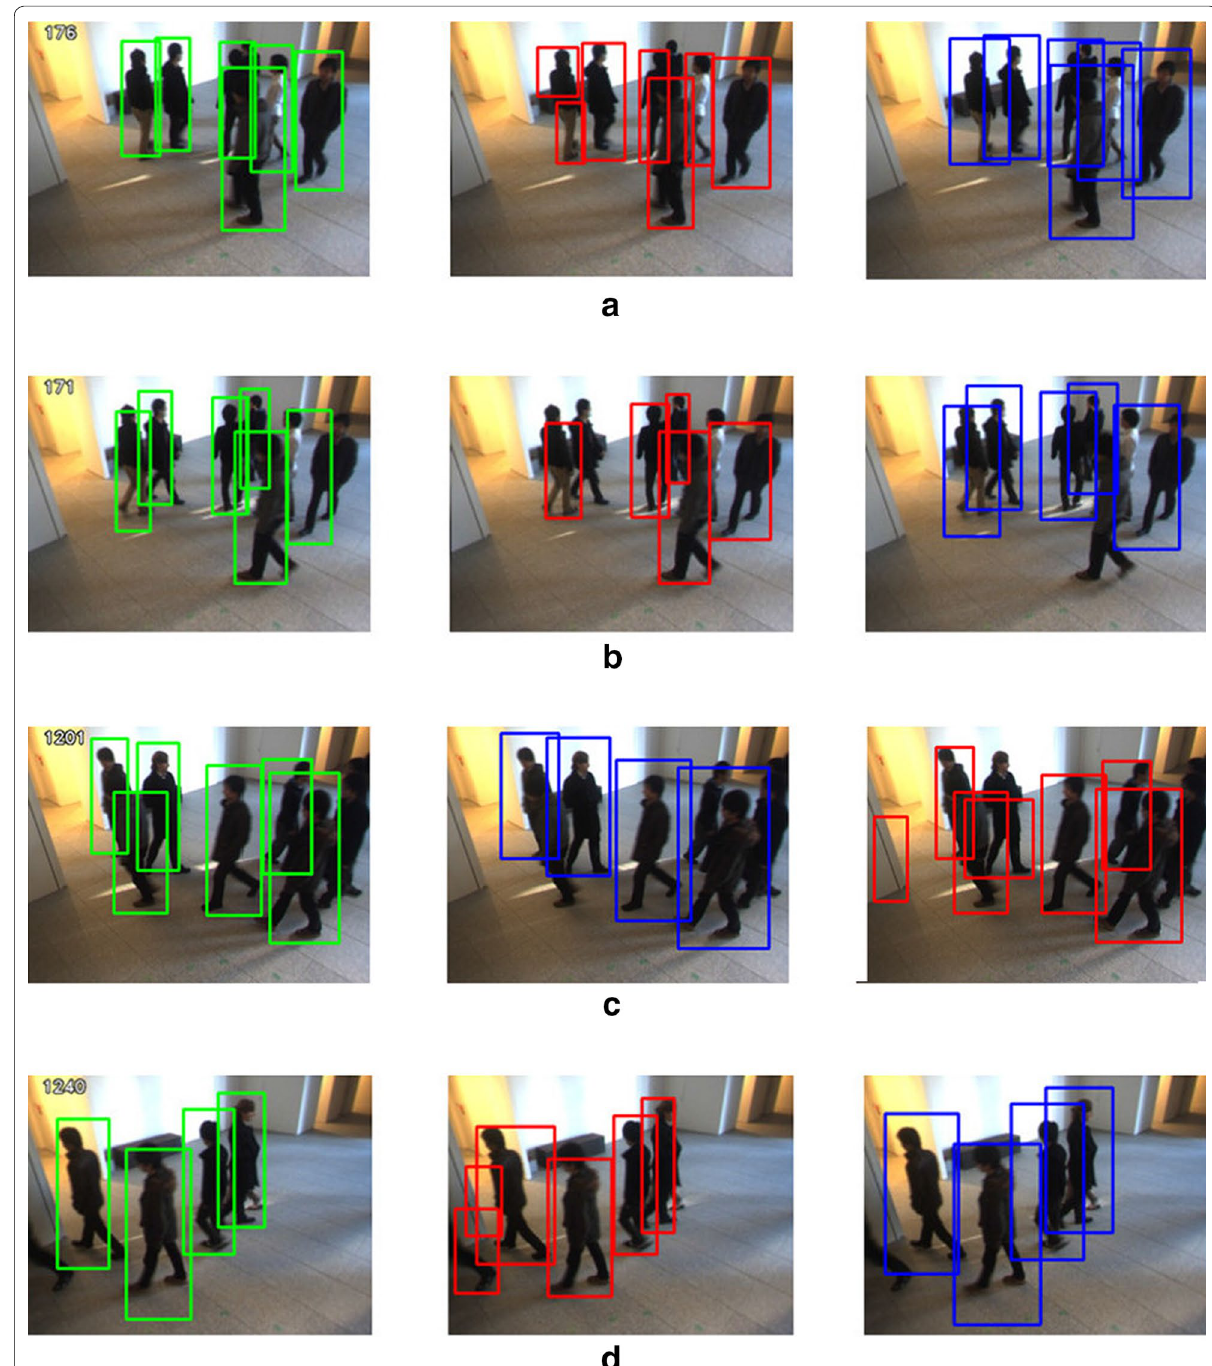
Fig. 11 Results of detection. a 171st frame, b 176th frame, c 1201st frame, d 1240th